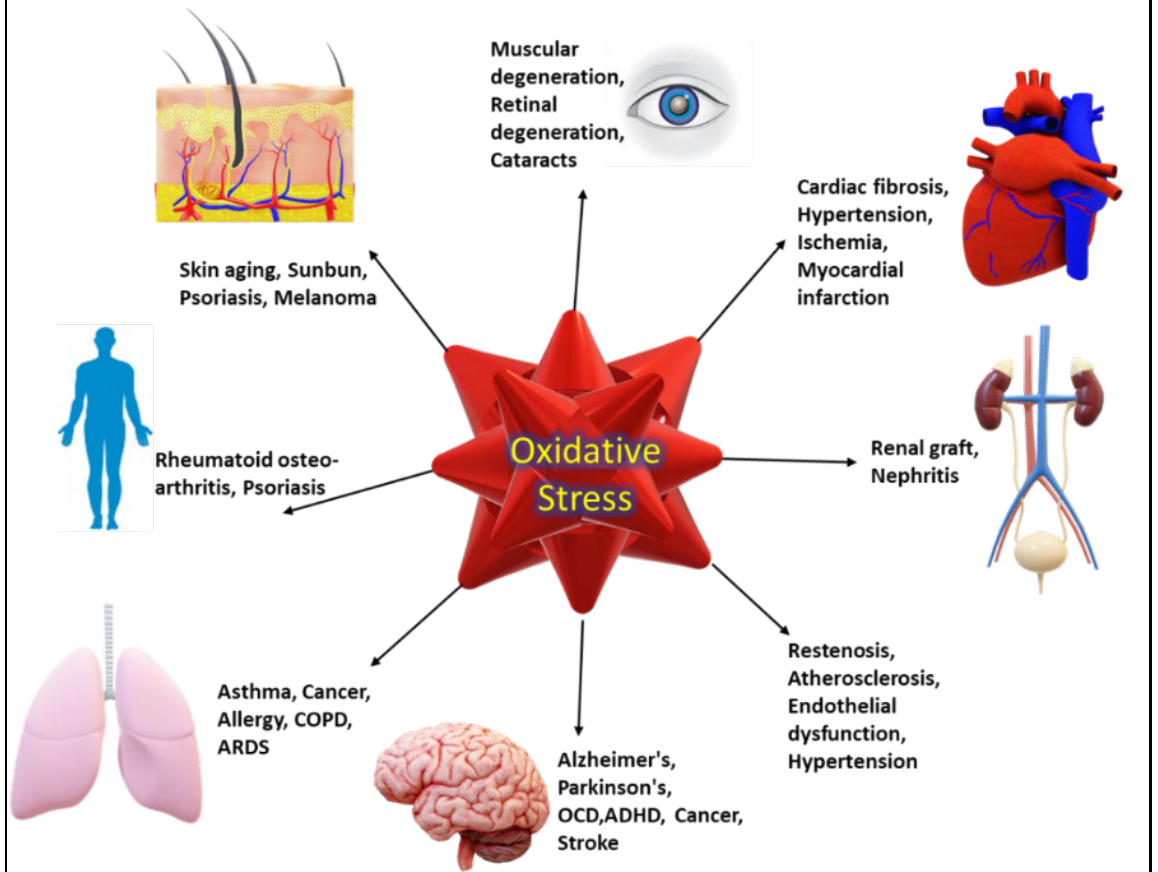
Figure 1. Oxidative stress Adverse Impacts on Human Health.